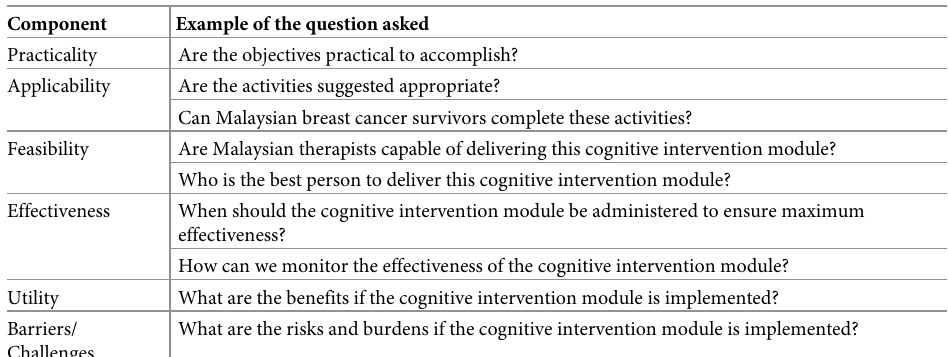
Table 2. Examples of items in the